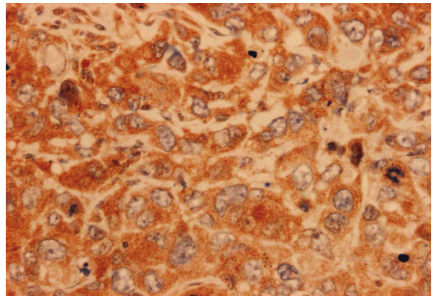
Figure 4: Positive cytoplasmic granular staining of tumour cells using anti-HD